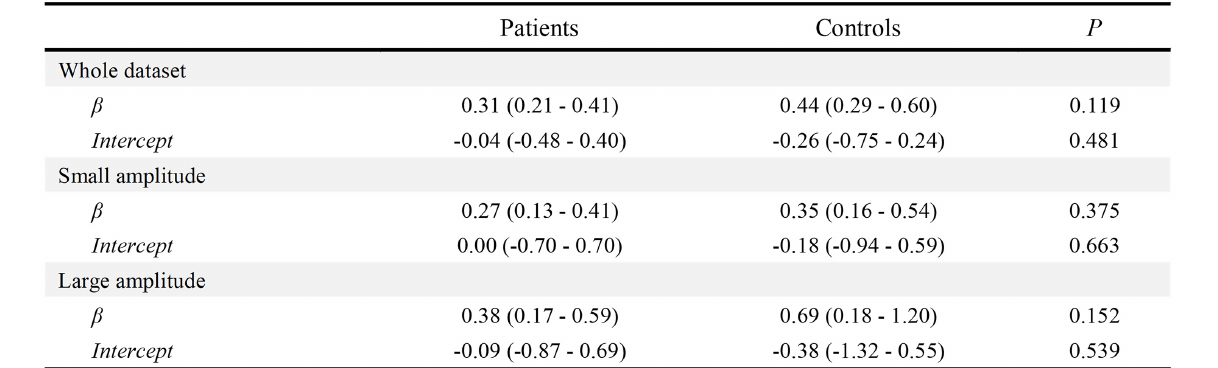
FIGURE 3 | The results of the velocity/acceleration task. (A) The results from the patient group (red line) are presented above on the regression results from the age-matched control group (blue line). (B) The results of statistical analyses for the velocity/acceleration task. Statistical analyses were performed using the generalized linear model with logit fit. IpL, ipsilesional; CoL, contralesional; PSE, point of subjective equality, which is the stimulus amplitude that corresponds to the 0.5 probability